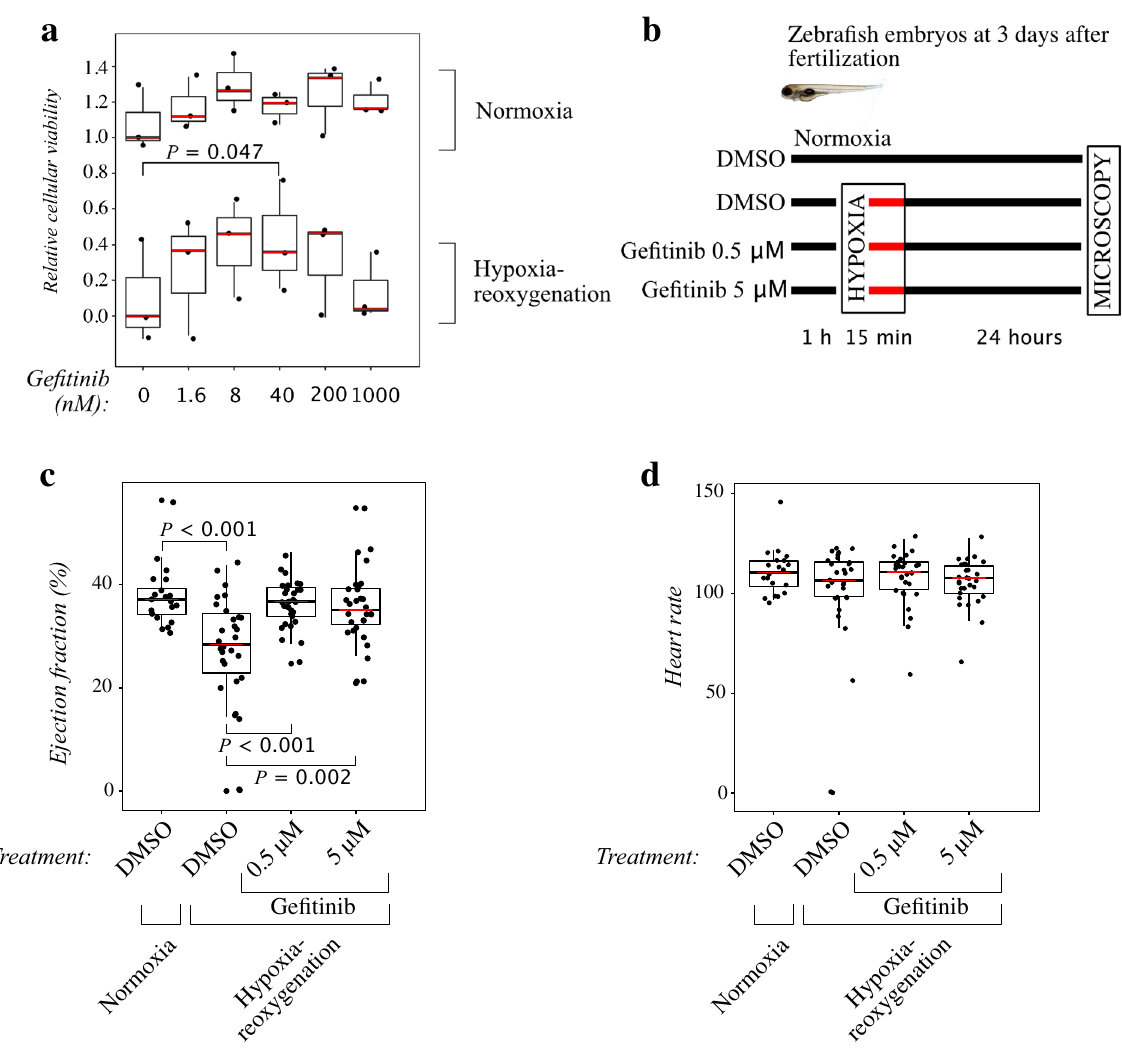
Figure 4. Effects of gefitinib on cardiomyocytes and zebrafish embryos challenged with hypoxia-reoxygenation. ( a ) Cellular viability of HL-1 cells treated with increasing concentrations of gefitinib. Cells were cultured in normoxia or exposed to 24-h hypoxia followed by 24-h reoxygenation. Cellular viability was measured using CTG assays. N = 3. One-way ANOVA followed by paired T-test and FDR-correction of P values were used for statistical analyses. Data were normalized by setting the median viability of untreated, normoxic controls to one and median viability of hypoxia-reoxygenation treated control samples to zero. ( b ) Outline of zebrafish embryo experiments. Embryos were treated for 1 h with 0, 0.5 or 5 μM of gefitinib before being exposed to hypoxia for 15 min and reoxygenation for 24 h. ( c , d ) Ventricular ejection fraction ( c ) and heart rate ( d ) of zebrafish embryos exposed to 15 min of hypoxia followed by reoxygenation for 24 h. The embryos were treated with 0, 0.5 or 5 μM of gefitinib. N = 20 for embryos in normoxia, n = 30 for all groups treated with